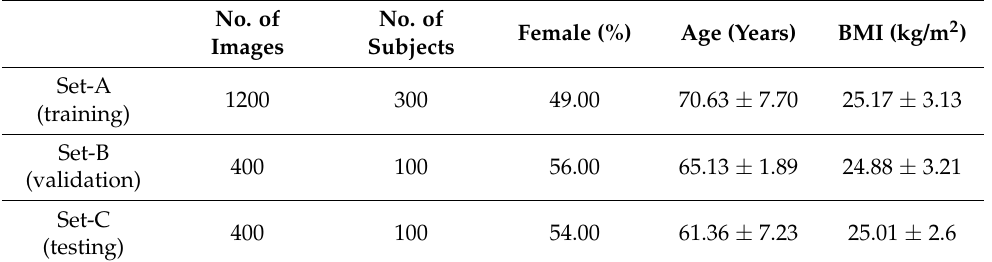
Table 2. Details of training, validation, and test set formed from DeepDRiD regular fundus images. BMI: body mass index.